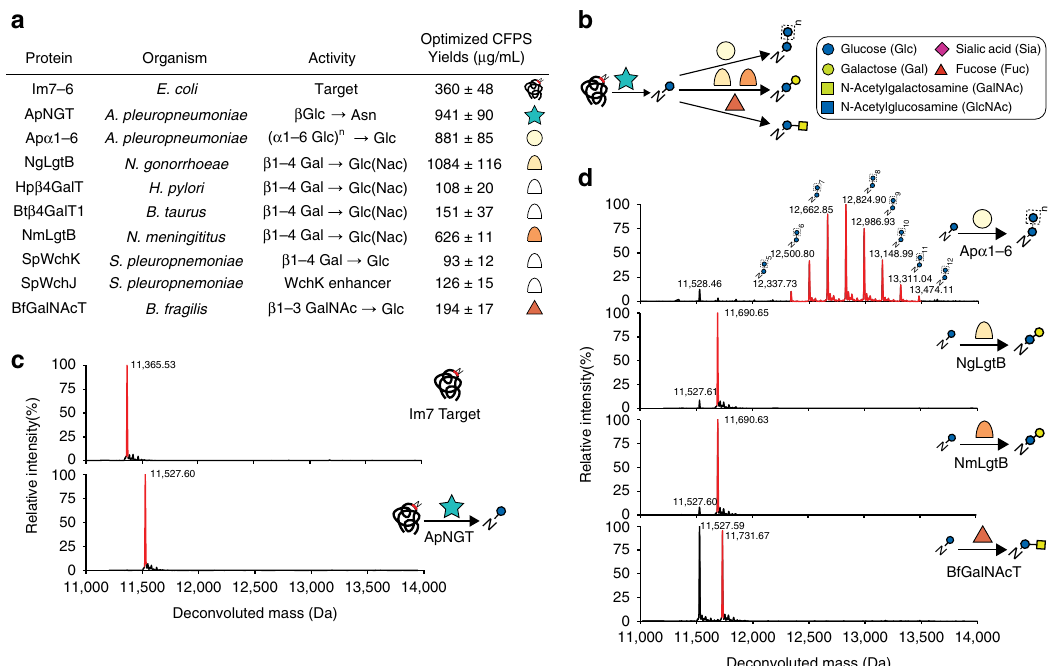
Fig. 2 In vitro synthesis and assembly of one- and two-enzyme glycosylation pathways. a Protein name, species, previously characterized activity and optimized soluble CFPS yields for Im7-6 target protein, ApNGT, and GTs selected for glycan elaboration. References for previously characterized activities in Supplementary Table 4. CFPS yields indicate mean and standard deviation (s.d.) from n = 3 CFPS reactions quanti fi ed by [ 14 C]-leucine incorporation. Full CFPS expression data in Supplementary Table 2 and Supplementary Figs. 1 – 2. b Symbol key and successful pathways for N -linked glucose installation on Im7-6 by ApNGT and elaboration by selected GTs. Glycan structures in this article use Symbol Nomenclature for Glycans (SNFG) and Oxford System conventions for linkages. Sialic acid refers to N -acetylneuraminic acid. c Deconvoluted mass spectrometry spectra from Im7-6 protein puri fi ed from IVG reactions assembled from CFPS reaction products with and without 0.4 µ M ApNGT as well as 2.5 mM UDP-Glc. Full conversion to N -linked glucose was observed after 24 h at 30 °C. d Intact deconvoluted MS spectra from Im7 protein puri fi ed from IVG reactions containing 10 µ M Im7-6, 0.4 µ M ApNGT, and 7.8 µ M NmLgtB, 13.9 µ M NgLgtB, 3.1 µ M BfGalNAcT, or 9.4 µ M Ap α 1-6. IVG reactions were supplemented with 2.5 mM UDP-Glc as well as 2.5 mM UDP- Gal or 5 mM UDP-GalNAc as appropriate for 24 h at 30 °C. Observed mass shifts and MS/MS fragmentation spectra (Supplementary Fig. 3) are consistent with ef fi cient modi fi cation of N -linked glucose with β 1-4Gal, β 1-4Gal, β 1-3GalNAc, or α 1-6 dextran polymer. Theoretical protein masses found in Supplementary Table 3. Hp β 4GalT, Bt β 4GalT1, and SpWchJ + K did not modify the N -linked glucose installed by ApNGT (Supplementary Fig. 4). All spectra were acquired from full elution peak areas of all detected glycosylated and aglycosylated Im7-6 species and are representative of n = 3 independent IVGs. Spectra from m/z 100 – 2000 were deconvoluted into 11,000 – 14,000 Da using Bruker Compass Data Analysis maximum entropy method. Source data is available in the Source Data fi